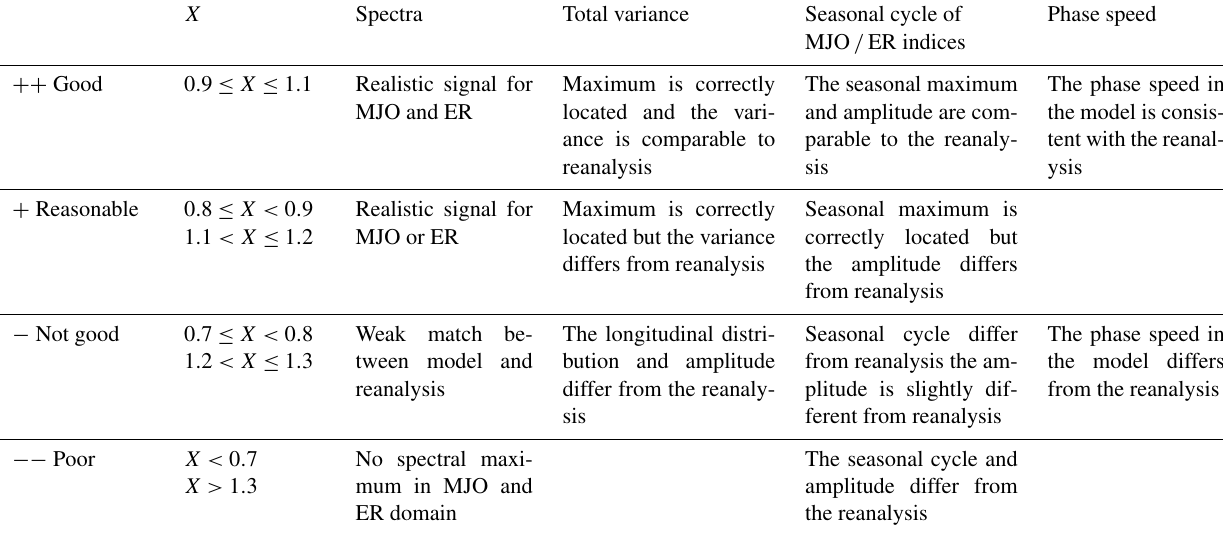
Table 4. Definition of the scale for classifying the models’ skill for Table